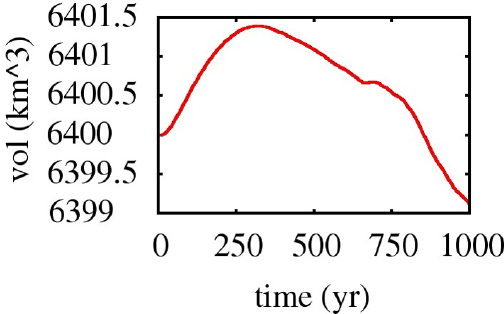
Fig. 7. Plot of the volume of the ice sheet at each of the time steps for the time-dependent ice-sheet flow experiment using the grid of resolution 80 × 80 ×